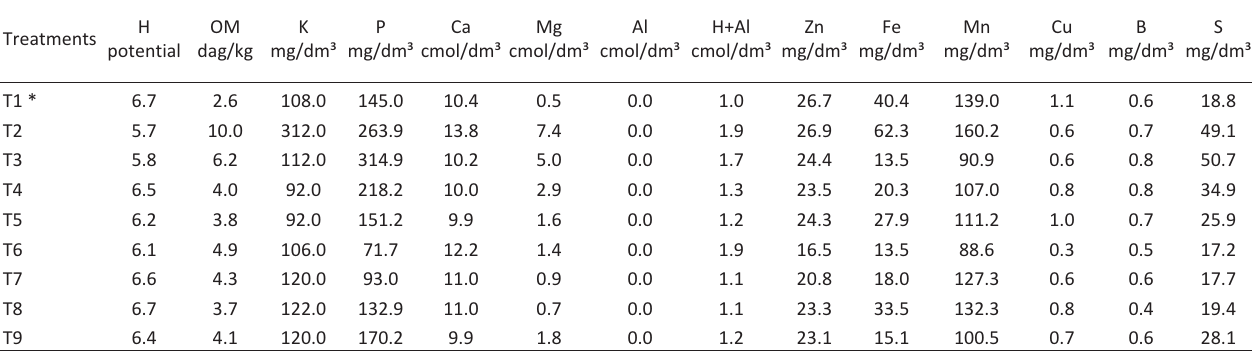
* T1= sand, T2= commercial substrate (OrganoAmazon © ), T3= 25% T1 + 75% manure, T4= 50% T1 + 50% manure, T5= 75% T1 + 25% manure, T6= 25% T1 + 75% burnt rice husks, T7= 50% T1 + 50% burnt rice husks, T8= 75% T1 + 25% burnt rice husks, T9= 25% soil + 25% sand + 25% manure + 25% burnt rice